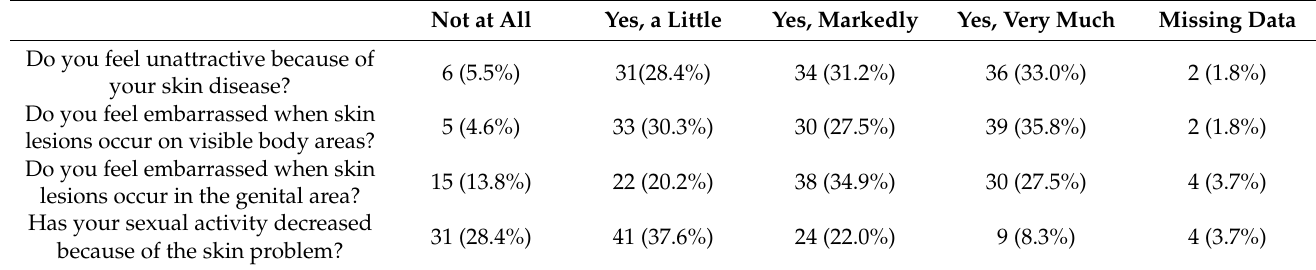
Table 3. Results regarding embarrassment and attractiveness level in studied